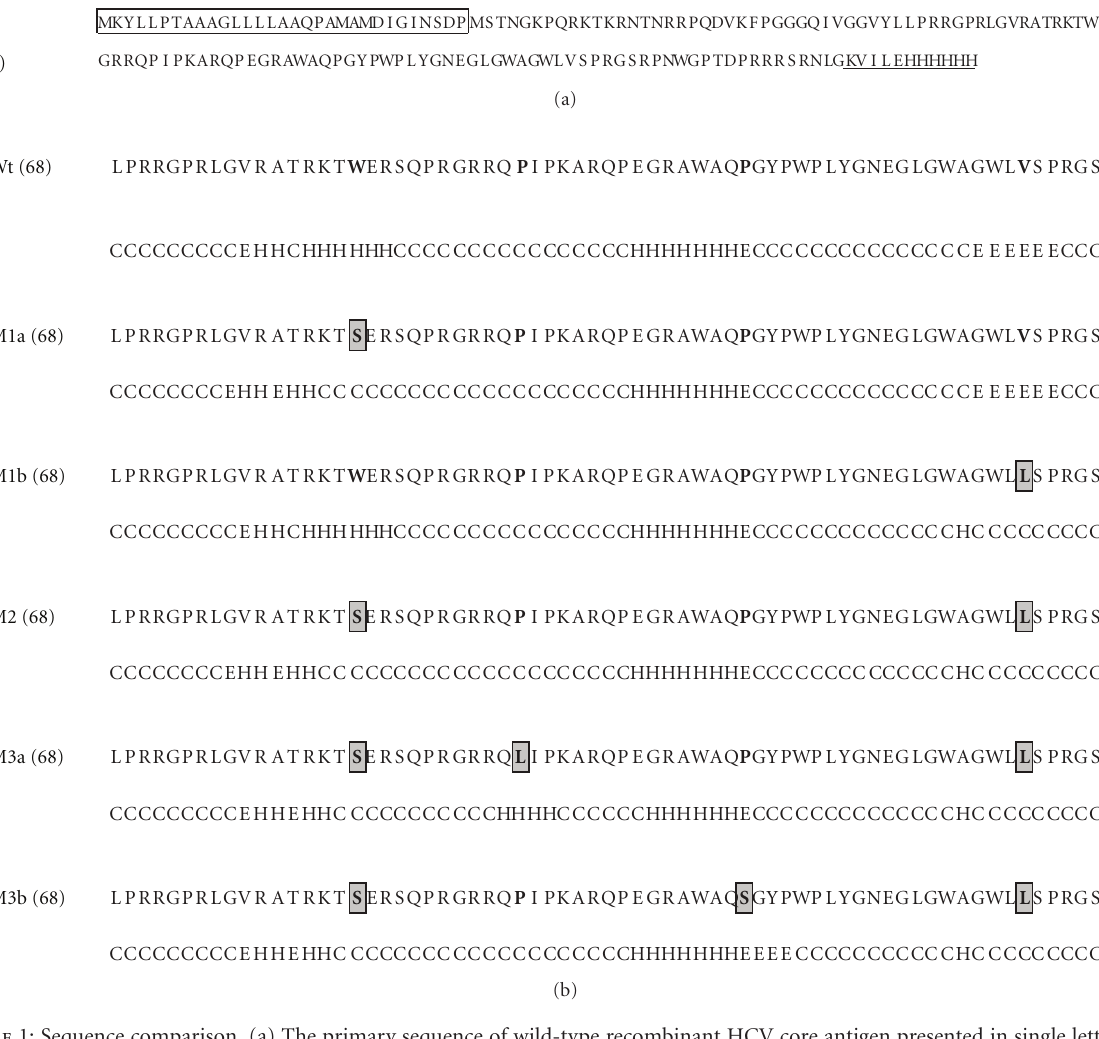
Figure 1: Sequence comparison. (a) The primary sequence of wild-type recombinant HCV core antigen presented in single letter code. It consists of three components: pelB leader (from aa 1 to aa 31 in border-box), HCV core fragment containing domain I (from aa 32 to aa 154, total 123 aa), and His tag (from aa 155 to aa 162, underlined). (b) Five mutants with higher antigenicities are aligned with wild-type antigen covering residues 68 to 137. Four high-frequency mutation points at W 84 , P 95 , P 110 , and V 129 are in boldface. The mutations are marked with a shaded box. The characters H, E, and C stand for alpha helices, beta strands, and random coil,